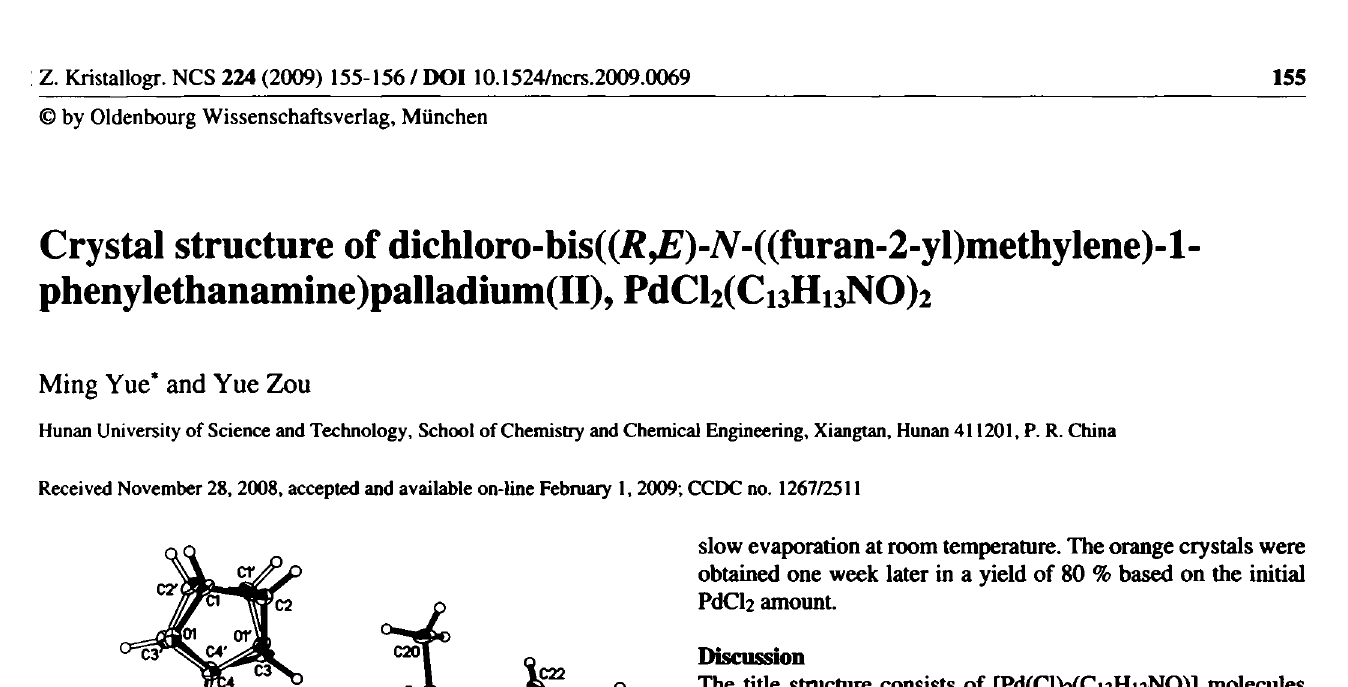
Table 1. Data collection and handling.